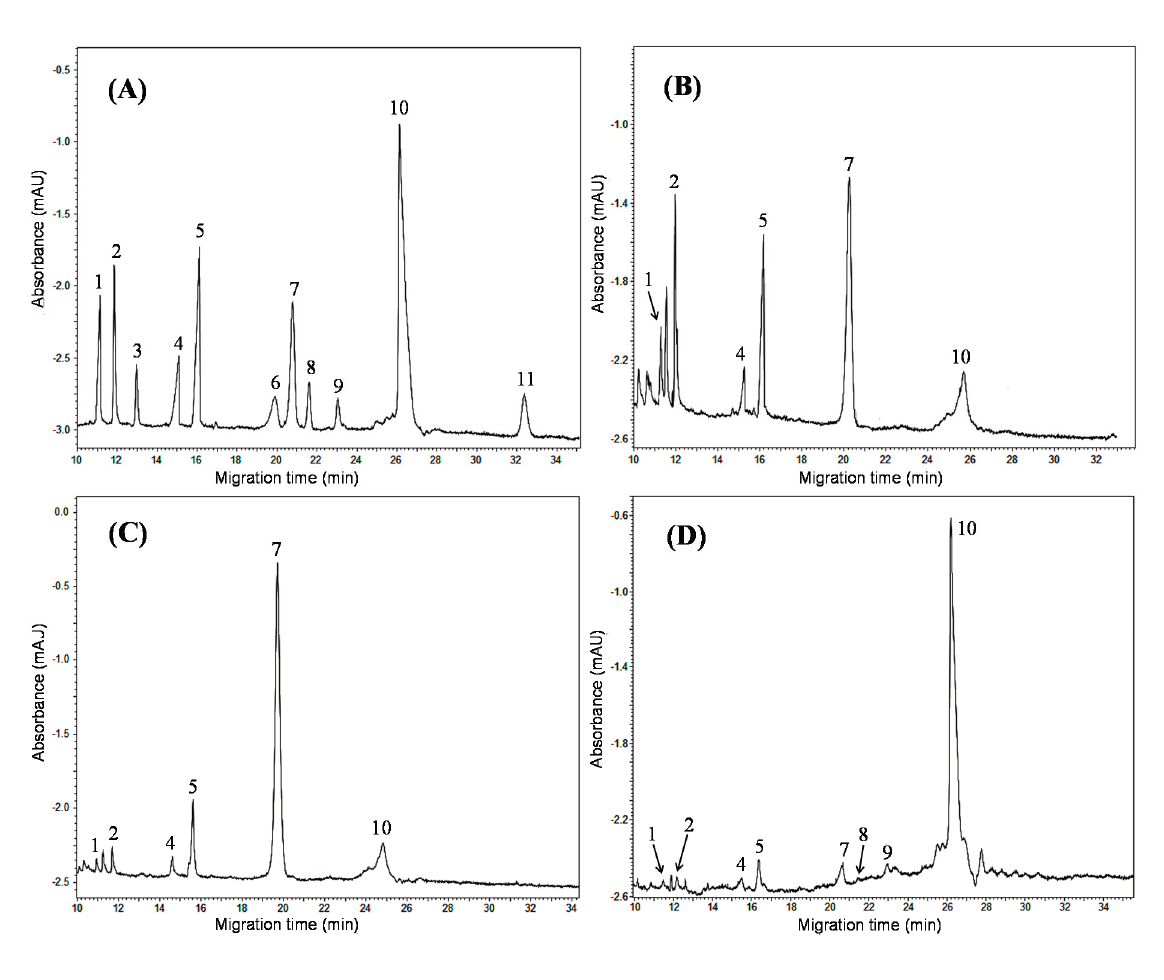
Figure 4. Typical electropherograms of the mixed standard solution and real samples under the optimal separation conditions. ( A ) Standard mixture (the concentrations are listed in Table 3); ( B ) No. 1, S. przewalskii ; ( C ) No. 2, S. castanea ; ( D ) No. 3, S.